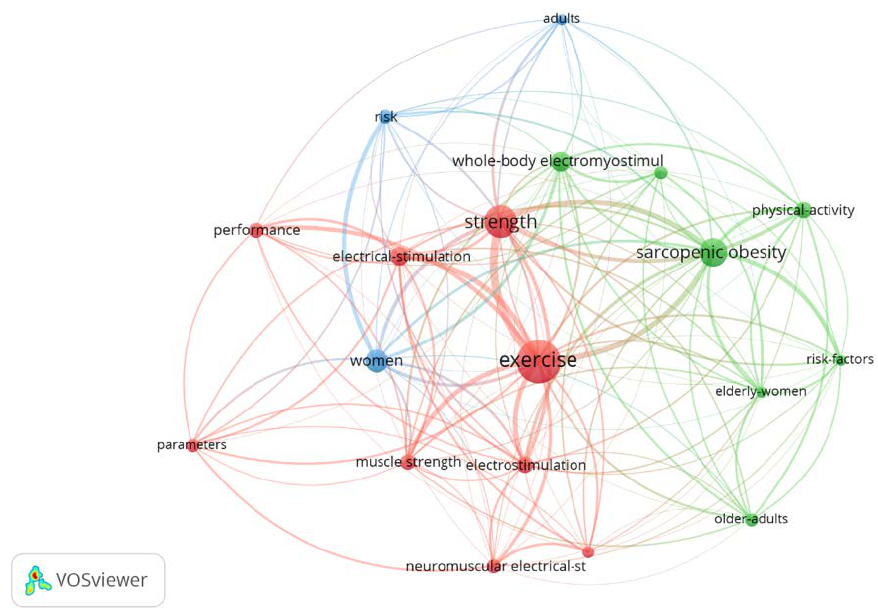
Figure 8. Graph with the most repeated keywords plus on WB-EMS.